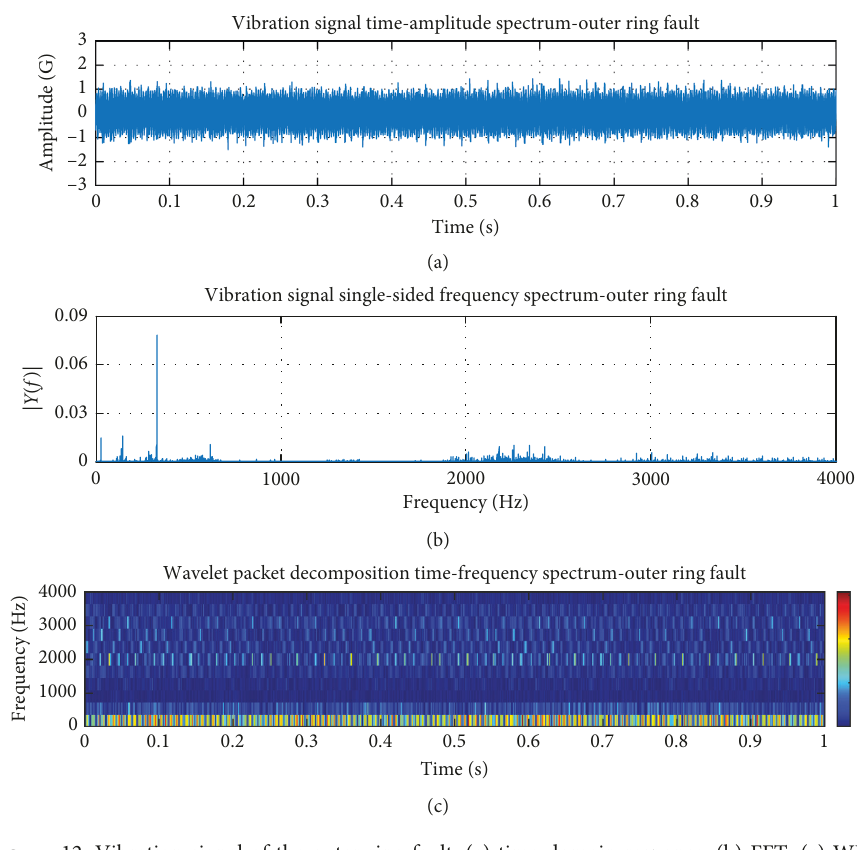
Figure 12: Vibration signal of the outer ring fault: (a) time-domain response; (b) FFT; (c)